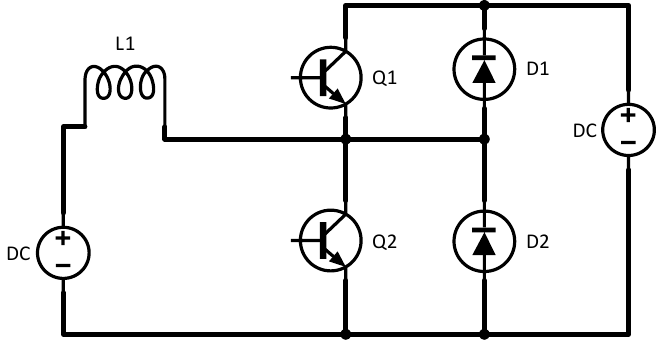
Figure 2. Bi-directional DC–DC converter.